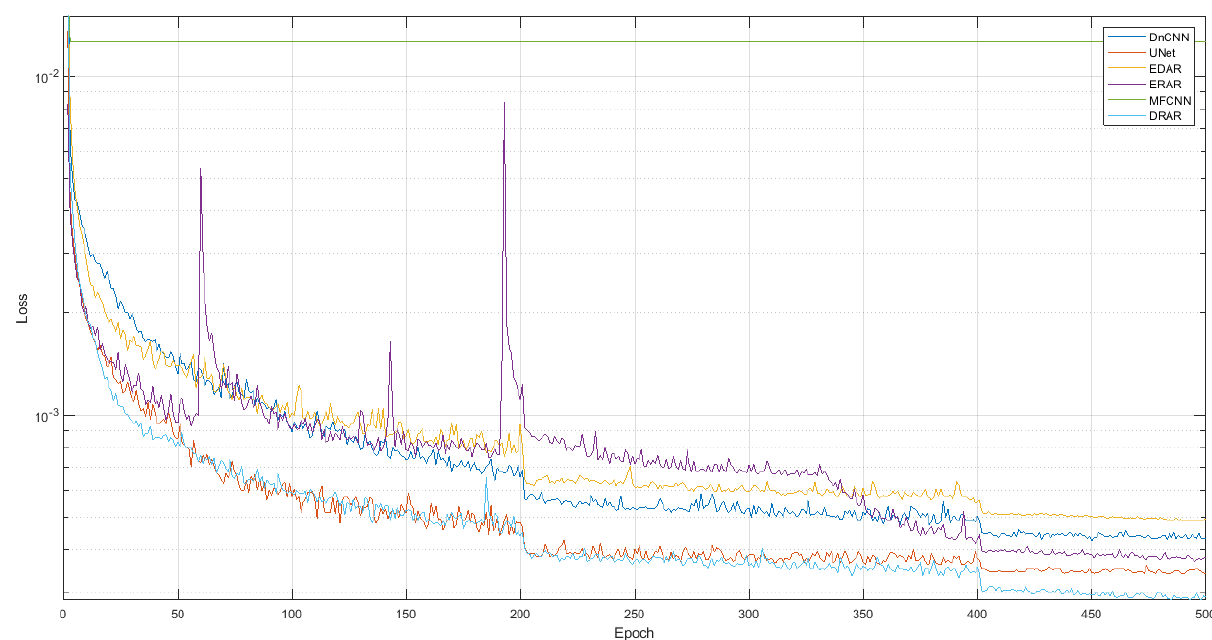
Figure 13. Loss value of DnCNN, ERAR, MFCNN, UNet, EDAR, and DRAR during training process.